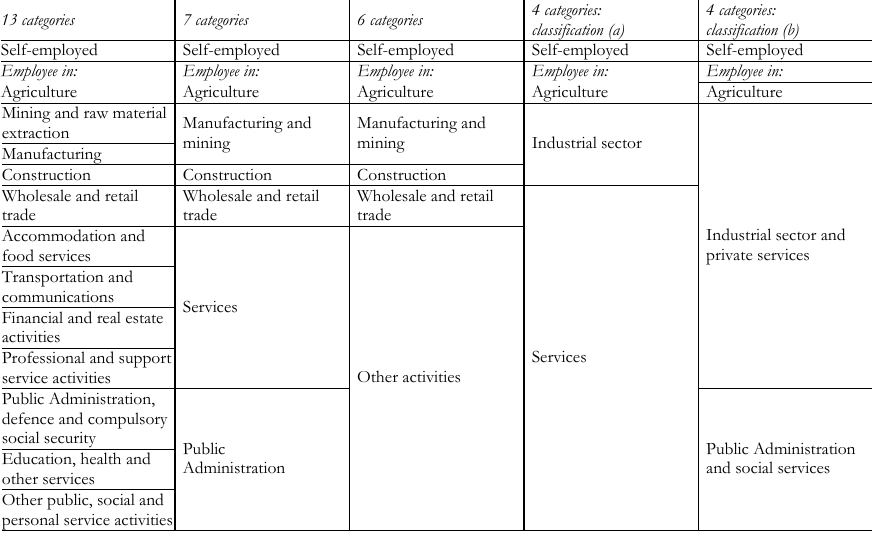
Scheme of categories aggregation process: joint classification by occupational status and industry